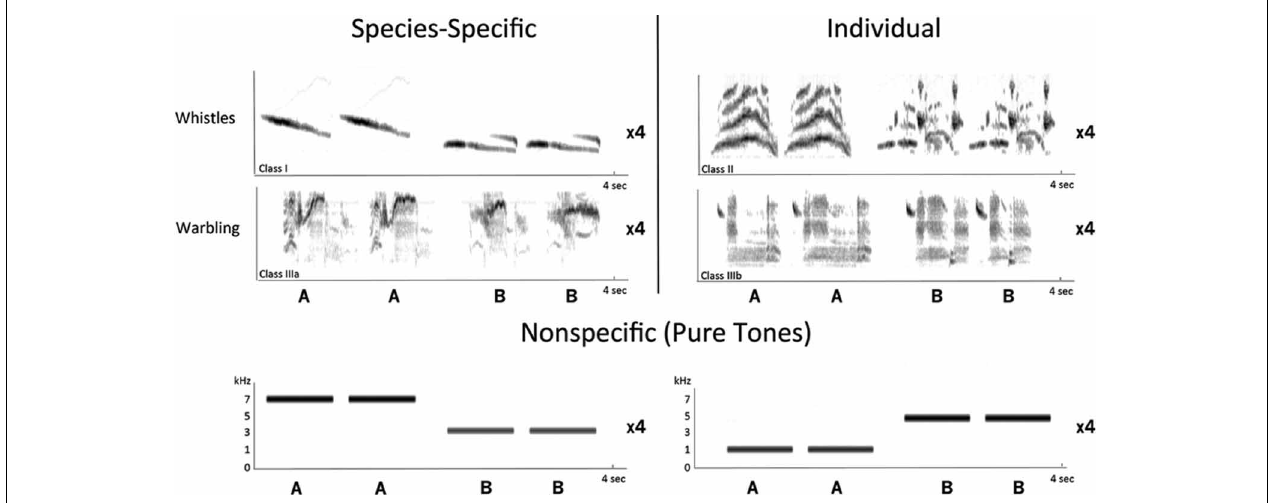
FIGURE 1 | Sonograms of the stimuli used in the experiment. Stimuli were divided according to the level of social information that they convey: stimuli bearing species-specific and group information consisted of 2 species-specific whistles and 2 species-specific warbling motifs; stimuli bearing individual information